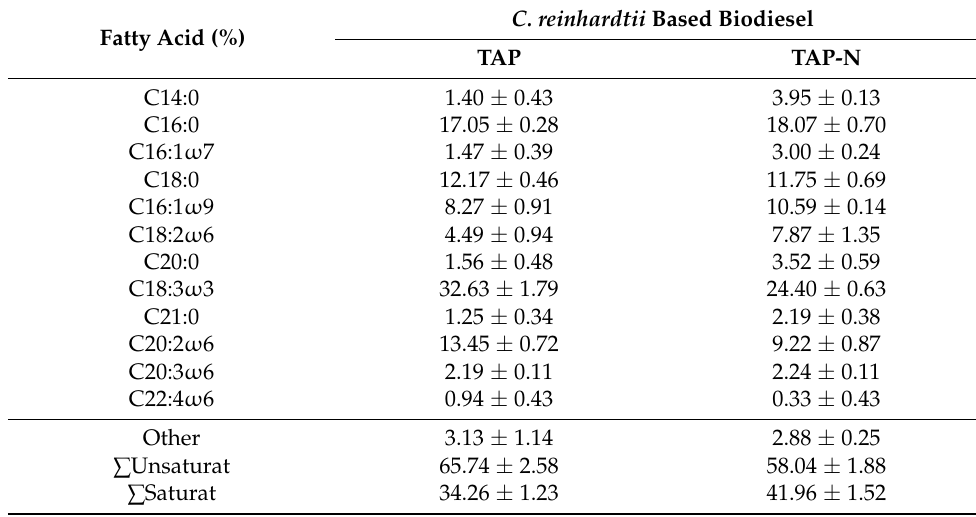
Table 1. Fatty acid profile (percentage of total fatty acids) of extracted lipids from C. reinhardtii, which were cultivated in nitrogen-replete medium (TAP) and in nitrogen deficiency medium (TAP-N). Values are means of three replicates. Cells harvested after 48 h of cultivation. Fatty Acid (%)